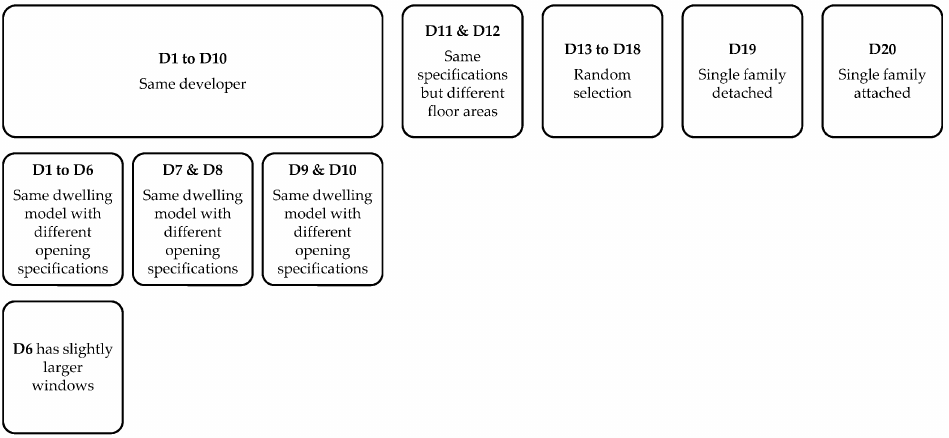
Figure 1. Visualization for the sample of tested dwellings.